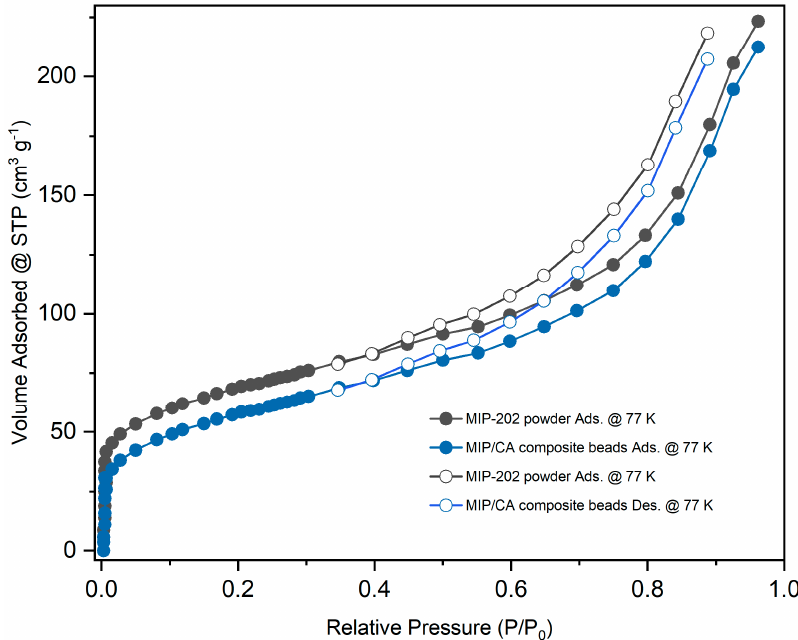
was 180 m 2 /g for MIP-202 powder and 160 m 2 /g for MIP-202/CA composite beads, diameters were measured to be 0.061 cm 3 /g and 2.52 nm for the free MIP-202 powder, respectively. These values were estimated to be 0.029 cm 3 /g for the total pore volume and 12.24 nm for the average pore diameters of MIP-202/CA composite beads. 12.24 nm for the average pore diameters of MIP-202/CA composite beads.